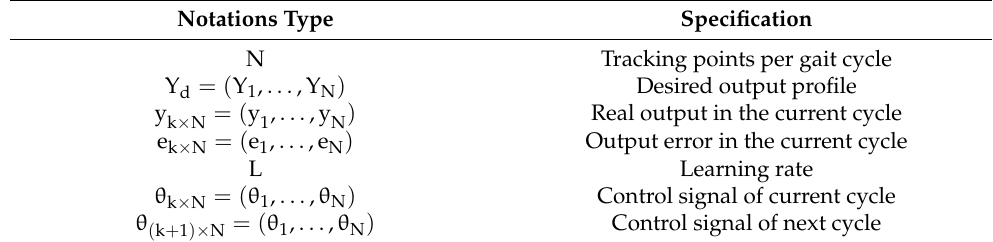
Table 2. ILC symbol table. Notations